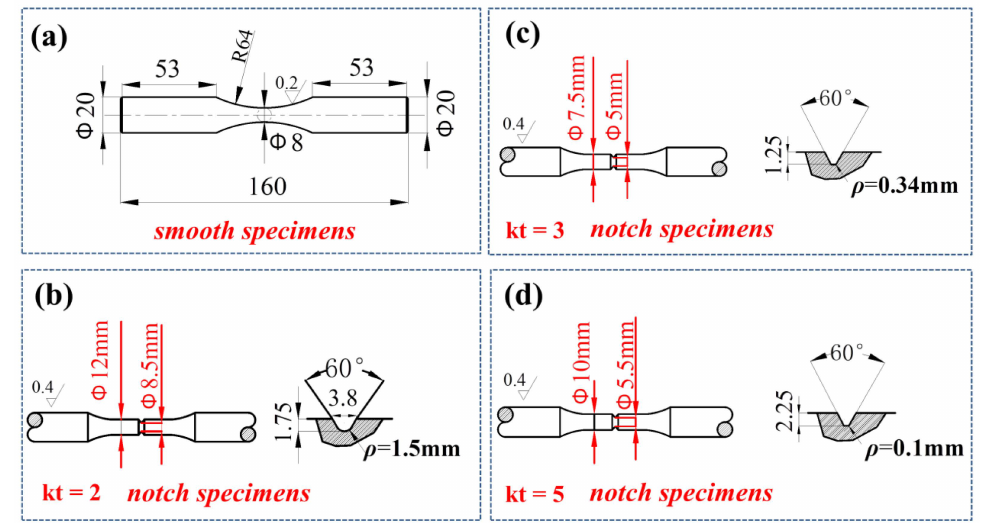
Figure 11. Geometries and dimensions of test specimens (in mm) used for S-N curve and notch specimens tests: ( a ) smooth specimen, and ( b ) circumferentially notched solid-bar specimen with kt = 2, ( c ) kt = 3, and ( d ) kt = 5.